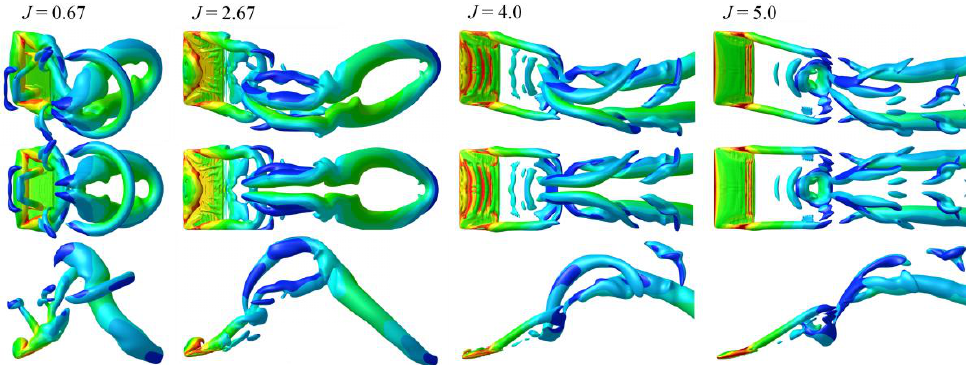
Figure 13. The flow field and vortex structure of a flapping foil with different advance coefficients ( L = 5.0, 𝐾 = 10.0 N. m/rad ).